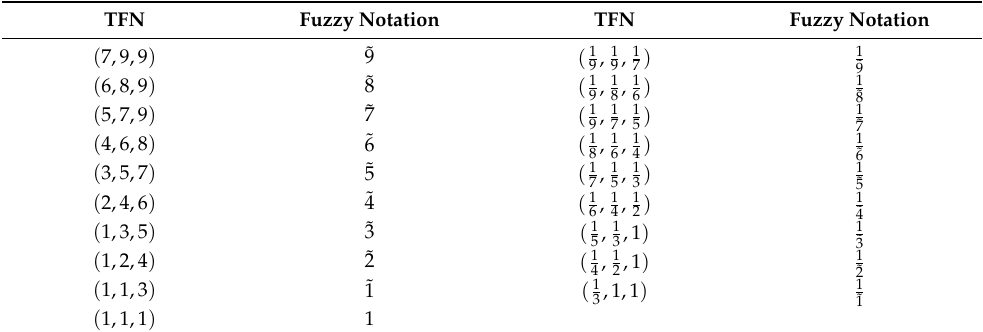
Table 3. Triangular fuzzy number table.